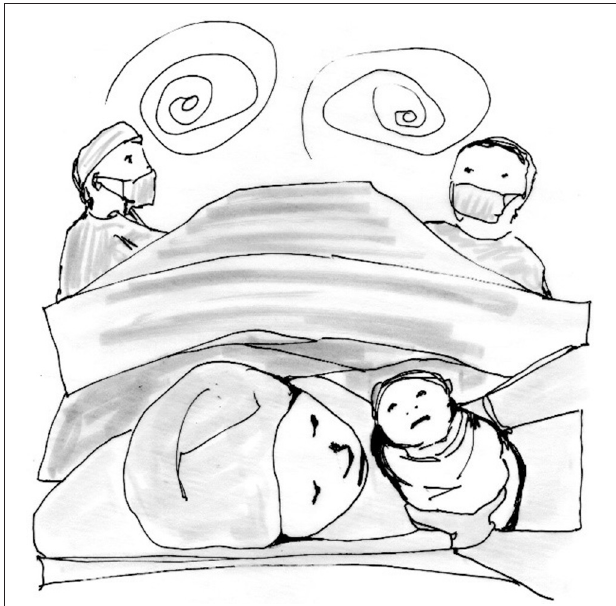
FIGURE 1 | Page 175 , a pen and ink drawing from the graphic novel by the author, Part One of The Pregnancy 6= Childbearing Project : A Phenomenology of Miscarriage (Rowman & Littlefield International, Feb 2017), © Jennifer